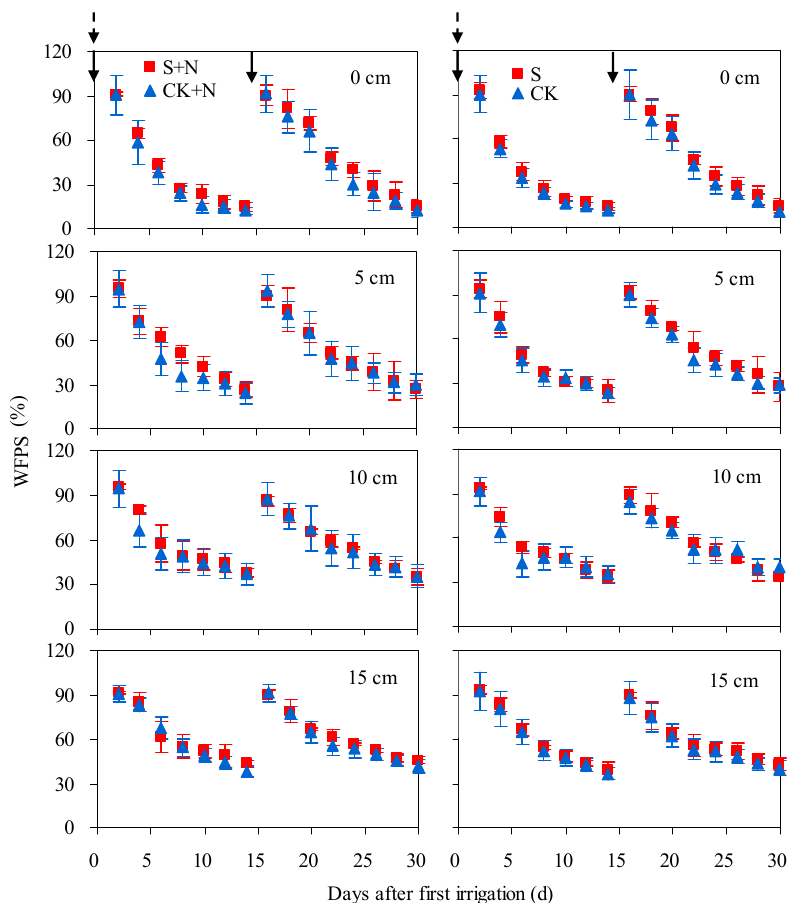
Figure 3. Soil WFPS at 0, 5, 10 and 15 cm depths after two irrigation events from 2 July to 18 August. Solid arrow and dotted arrow represent irrigation and fertilization event, respectively. S + N and S denotes the average WFPS from three saline water irrigated soils (S2, S5 and S8) with N120 and N0 application, respectively.